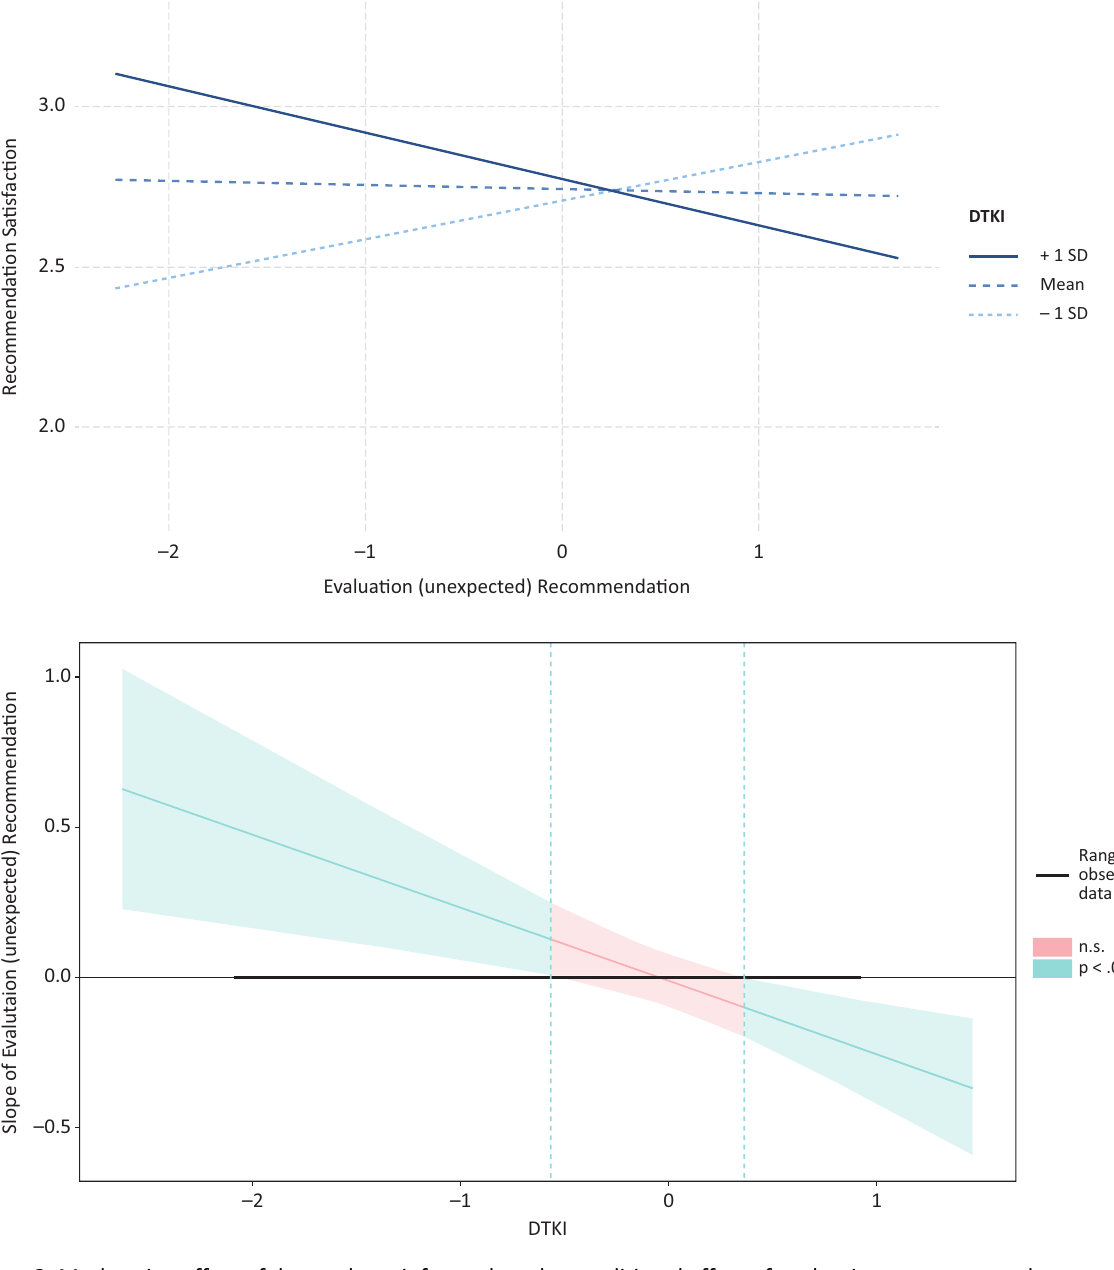
Figure 3. Moderating effect of duty to keep informed on the conditional effect of evaluation as unexpected on recommen‐ dation